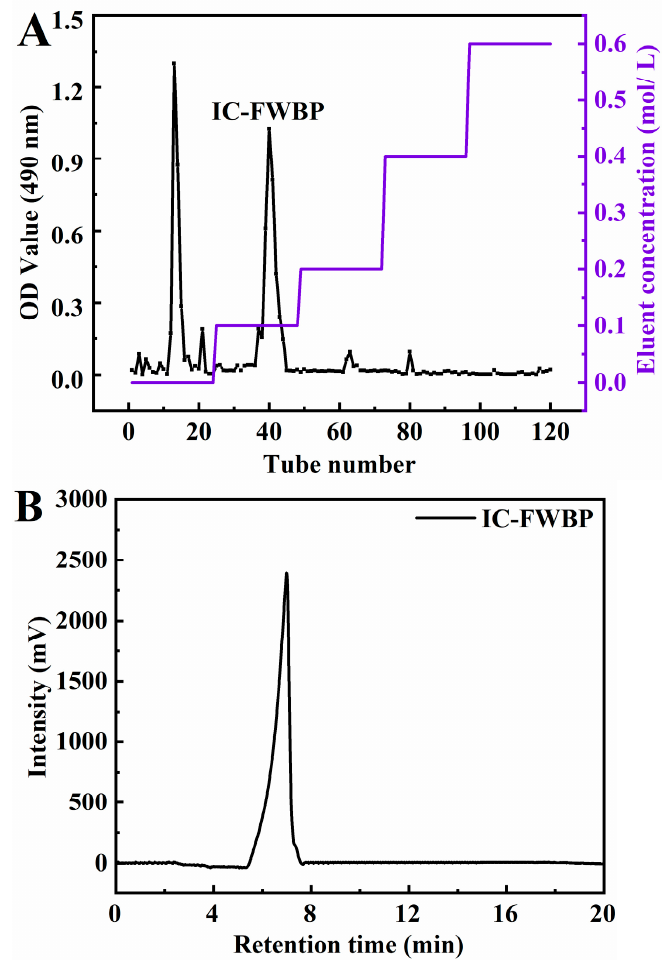
Figure 1. ( A ) Chromatography of the crude polysaccharides by DEAE-52 column; ( B ) HPLC profiles of